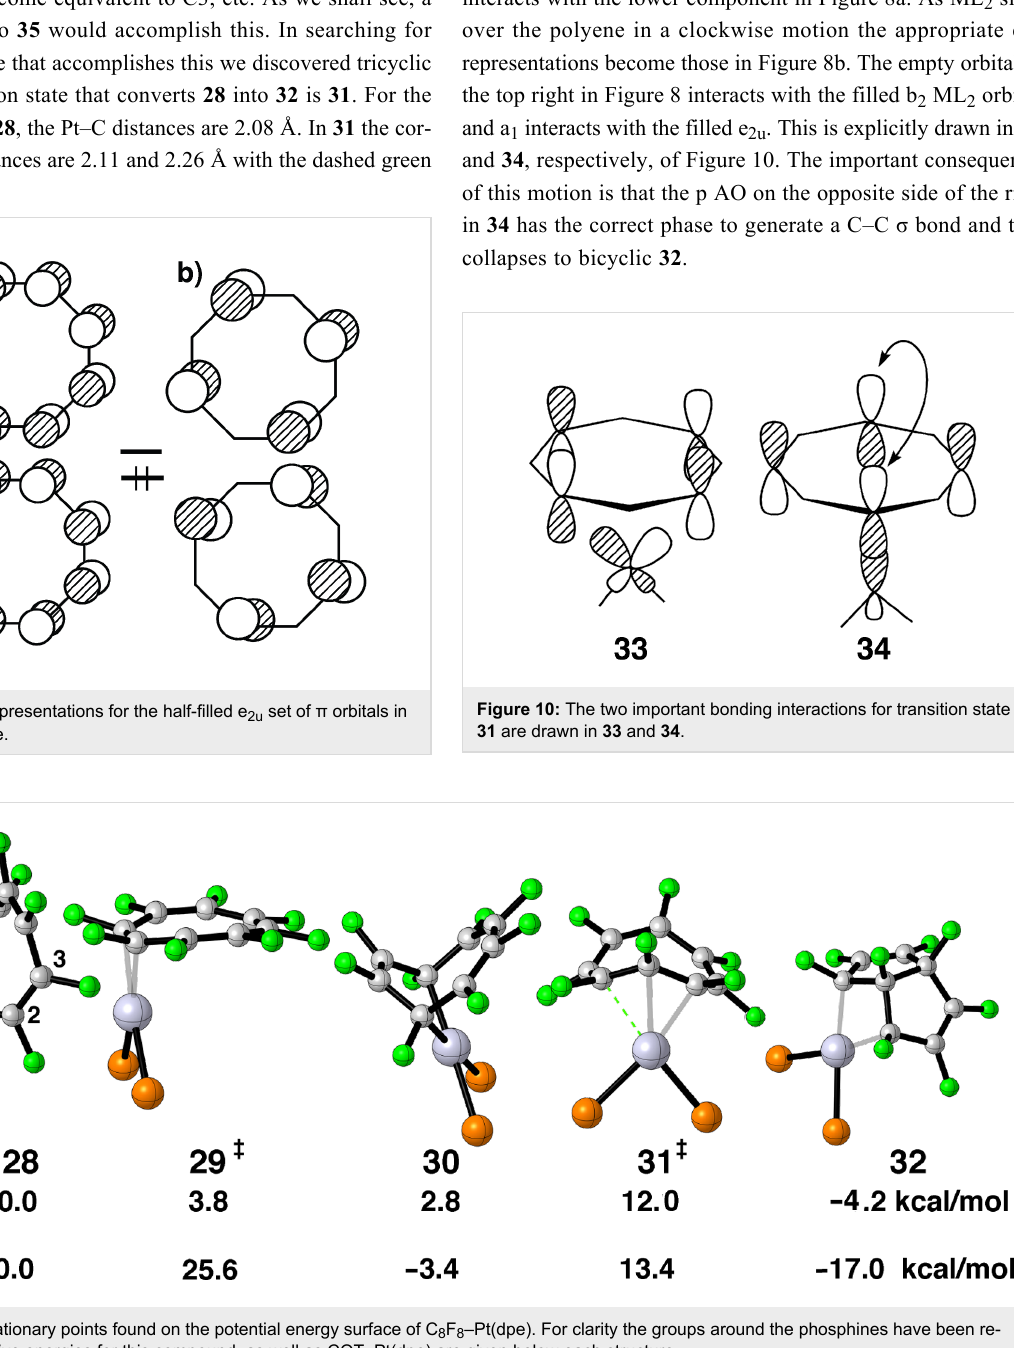
Figure 9: The stationary points found on the potential energy surface of C 8 F 8 –Pt(dpe). For clarity the groups around the phosphines have been re- moved. The relative energies for this compound, as well as COT–Pt(dpe) are given below each structure.